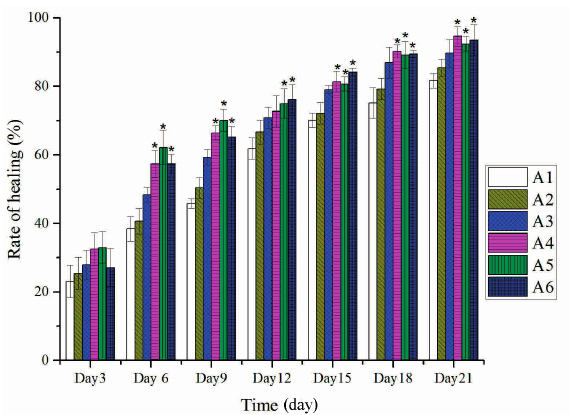
Figure 3. Effect of different concentration or fractions of BBO on the rate of wound healing in rats. Values are expressed as mean ± S.D. ( n = 4 animals). * : p < 0.05 vs. control.